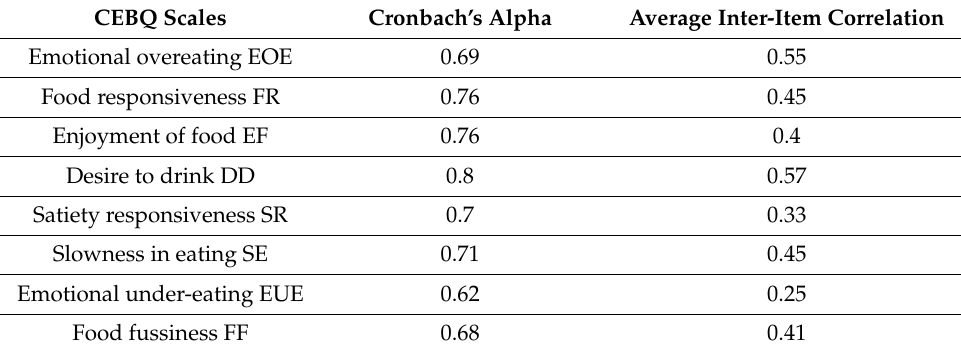
Table 3. Factor reliability of the CEBQ (N =